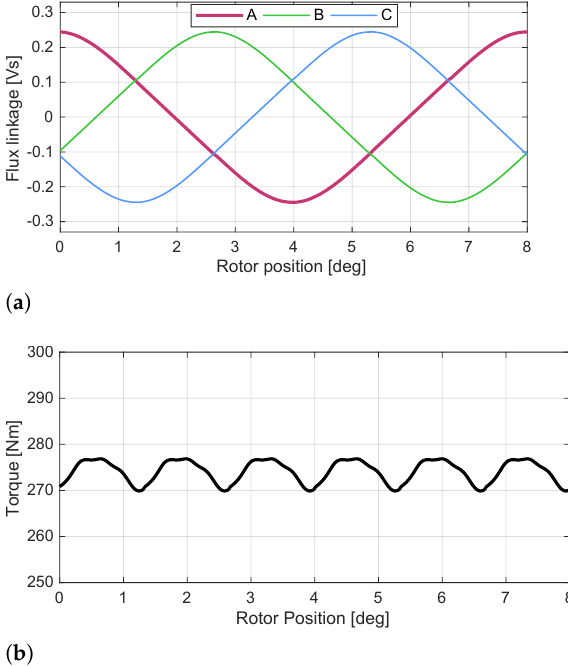
Figure 7. Analysis of the SPM motor. ( a ) Flux linkage, ( b ) Torque.